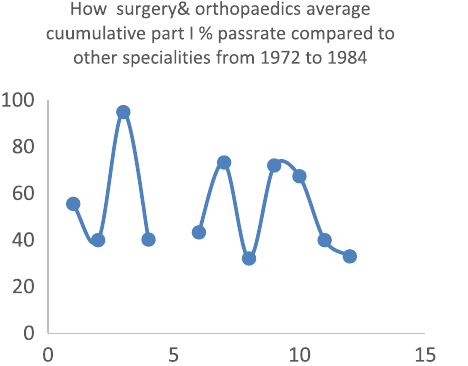
Fig. 6. How surgery & orthopaedics average cuumulative part I % passrate compared to other specialities from 1972 to